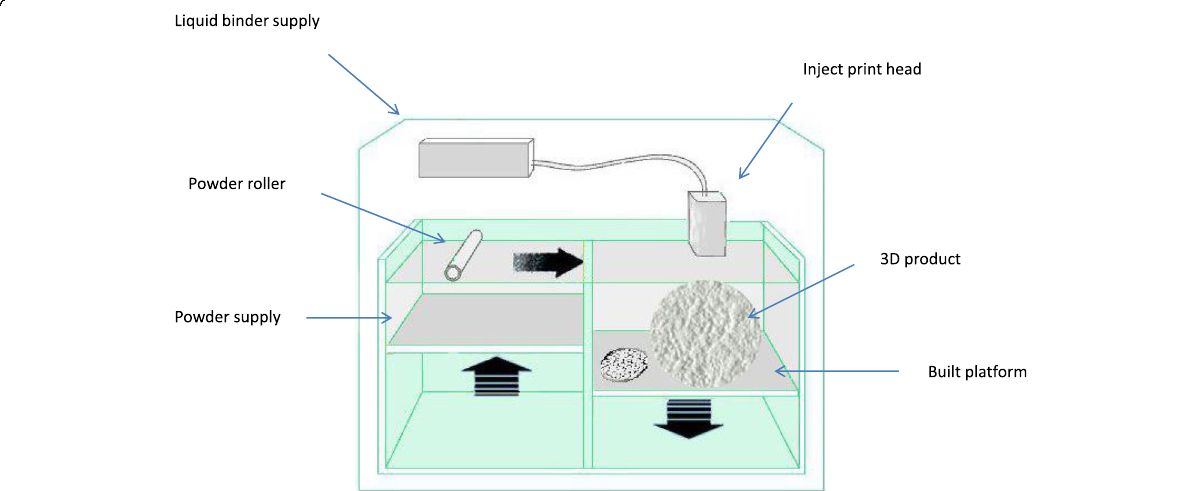
Fig. 4 Schematic illustration of powder bed binding